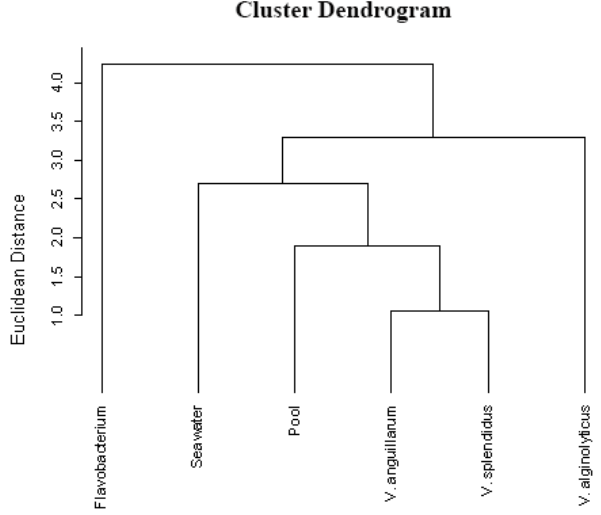
Fig. 2. Hierarchical clustering Dendrogram of Experimental con- dition ( Flavobacterium , pool of Vibrios, V. anguillarum , V. splen- didus , V. alginolyticus ) and Control (Seawater) of mussel B. azori- cus at 12h post-infection through Euclidean distance, using UP- GMA method.